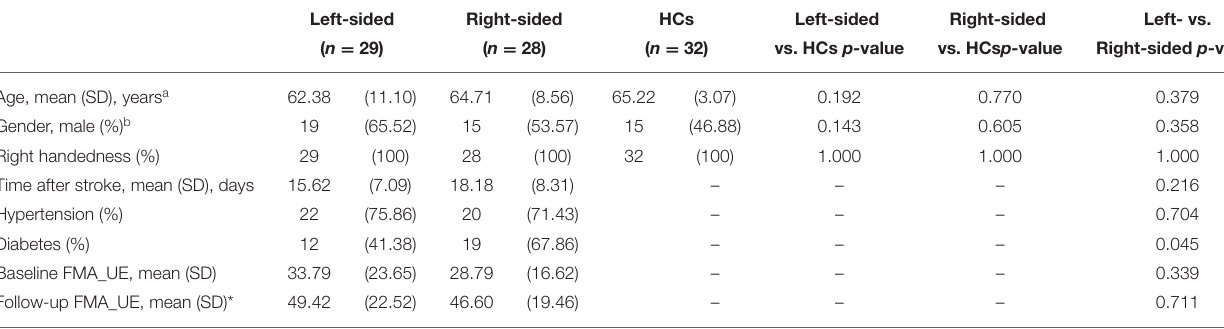
TABLE 1 | Demographic and clinical characteristics of left-sided and right-sided stroke patients and HCs. Left-sided Right-sided HCs Left-sided Right-sided Left- vs. ( n = 29) ( n = 28) ( n = 32) vs. HCs p- value vs. HCs p- value Right-sided p- value Age, mean (SD), years a 62.38